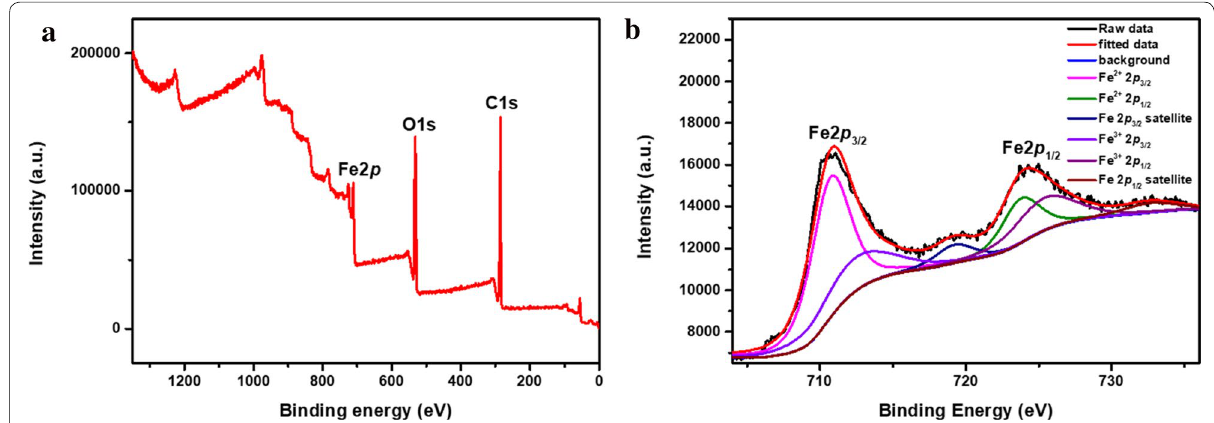
Fig. 4 XPS spectra of Fe@Fe 3 O 4 nanoparticles: survey spectrum ( a ) and Fe 2p XPS spectrum ( b